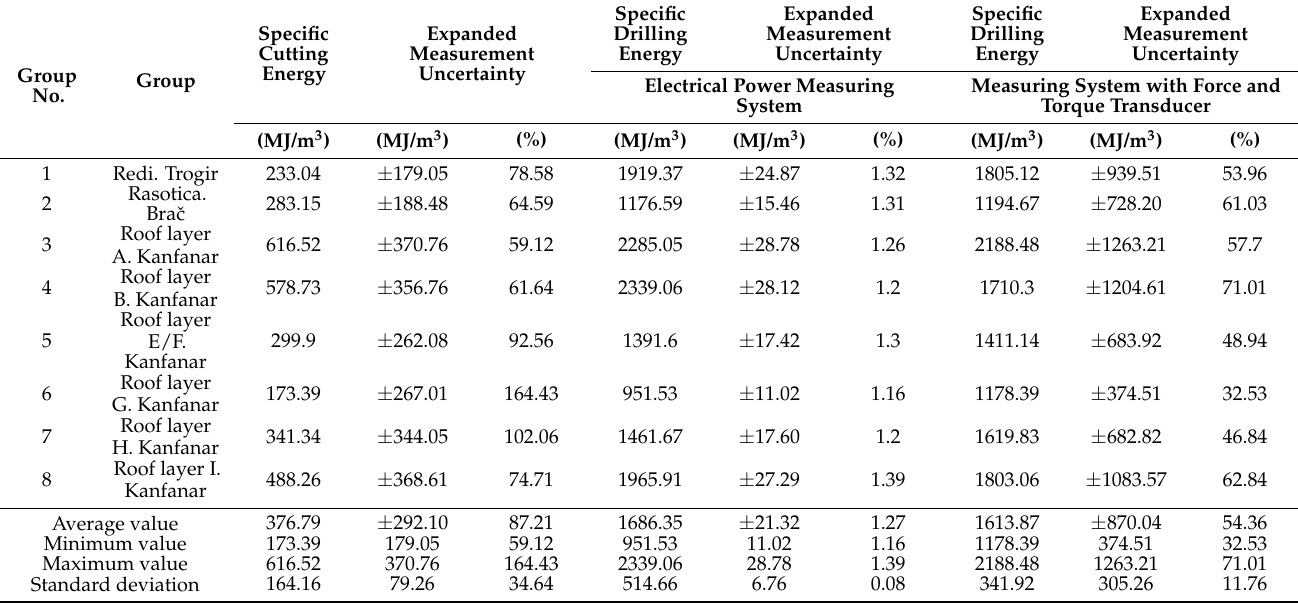
Table 4. Presentation of measurement results of specific cutting and drilling energies (both measuring systems) with corresponding measurement uncertainties.